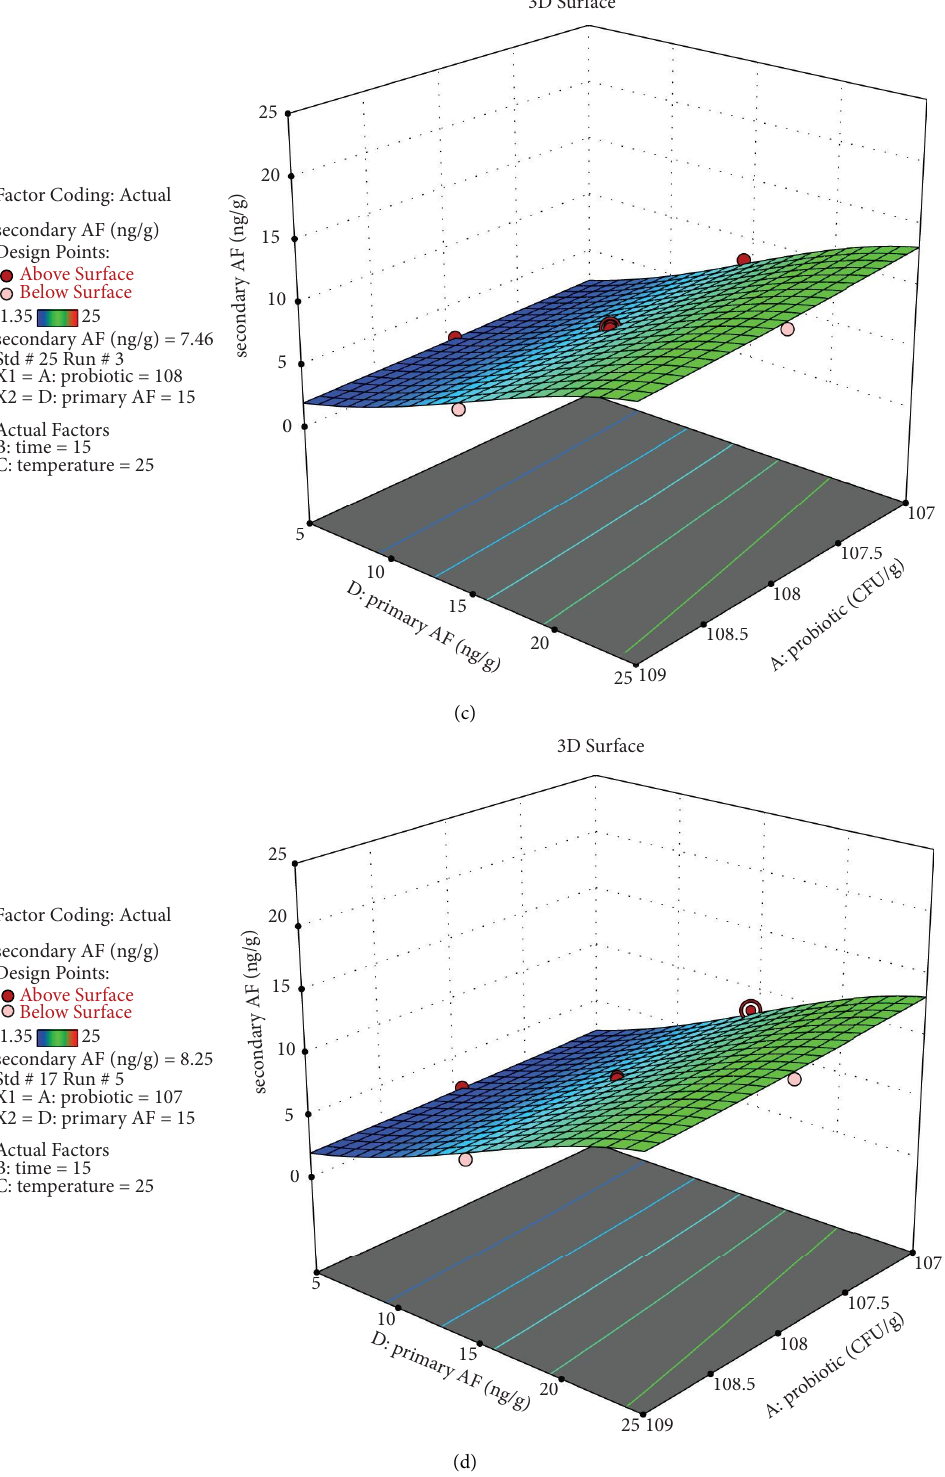
Figure 3: Interaction of time (15 days) and the storage temperature (25 ° C) on the afatoxin residue in pistachio